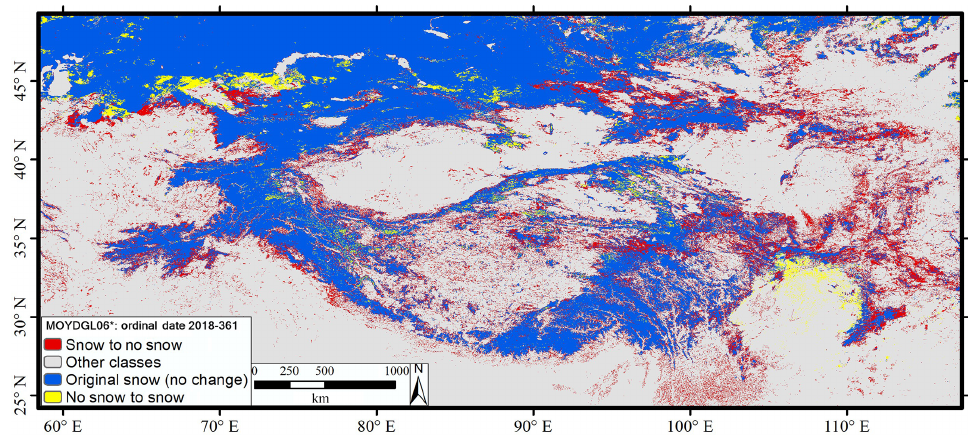
Figure 10. An example of the improved snow MOYDGL06* product showing the snow with no change, snow converted to no snow, and no snow converted to snow by our methodology in the combined Terra and Aqua product. The blue and yellow classifications are used in the MOYDGL06*